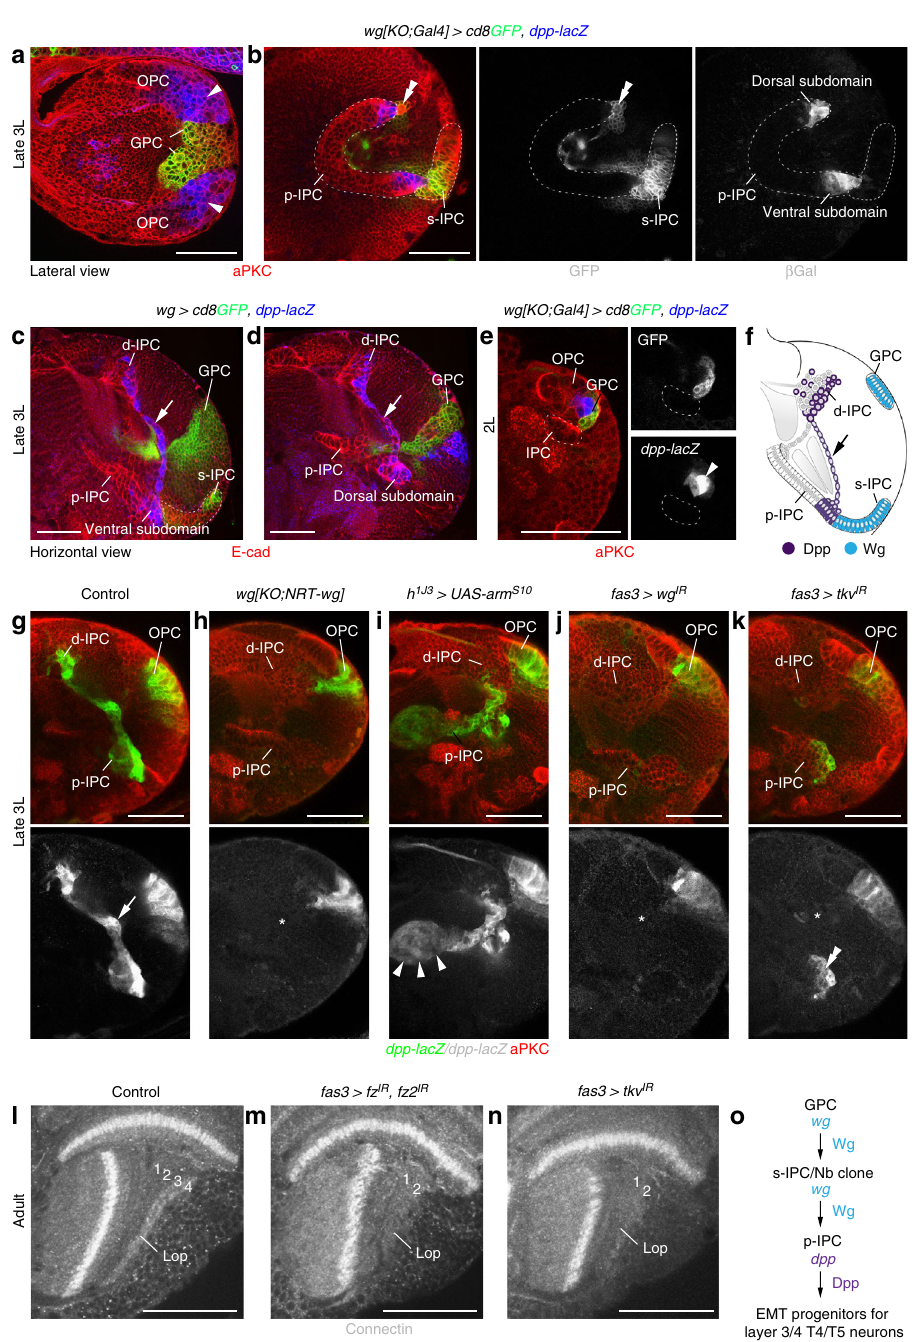
Fig. 3 s-IPC-derived Wg is required for Dpp-dependent EMT in the p-IPC. a , b In 3rd instar larvae (3L), dpp-lacZ (blue) was detected in subdomains adjacent to wg{KO;Gal4} UAS-cd8GFP (green) regions in the dorsal and ventral OPC ( a , arrowheads) and p-IPC ( b ). Double arrowhead indicates GFP- positive Nb clone adjacent to the dorsal p-IPC. c , d dpp-lacZ (blue) was maintained in progenitor streams (arrows) from the ventral and dorsal p-IPC subdomains. e In 2nd instar larvae (2L), dpp-lacZ (blue) was present in the OPC (arrowhead) adjacent to wg{KO;Gal4} UAS-cd8GFP- positive GPC areas (green), but was absent in the IPC (dashed line). f Schematic illustrating Wg and Dpp expression domains. Arrow indicates progenitor stream originating from the ventral p-IPC subdomain. g – k Unlike in controls ( g , arrow), dpp-lacZ (green) was absent from the IPC in wg{KO;NRT-wg} fl ies ( h , asterisk). The OPC was not affected. dpp-lacZ was ectopically induced in the IPC (arrowheads) by h 1J3 -Gal4 -mediated expression of UAS-arm S10 ( i ). dpp-lacZ was